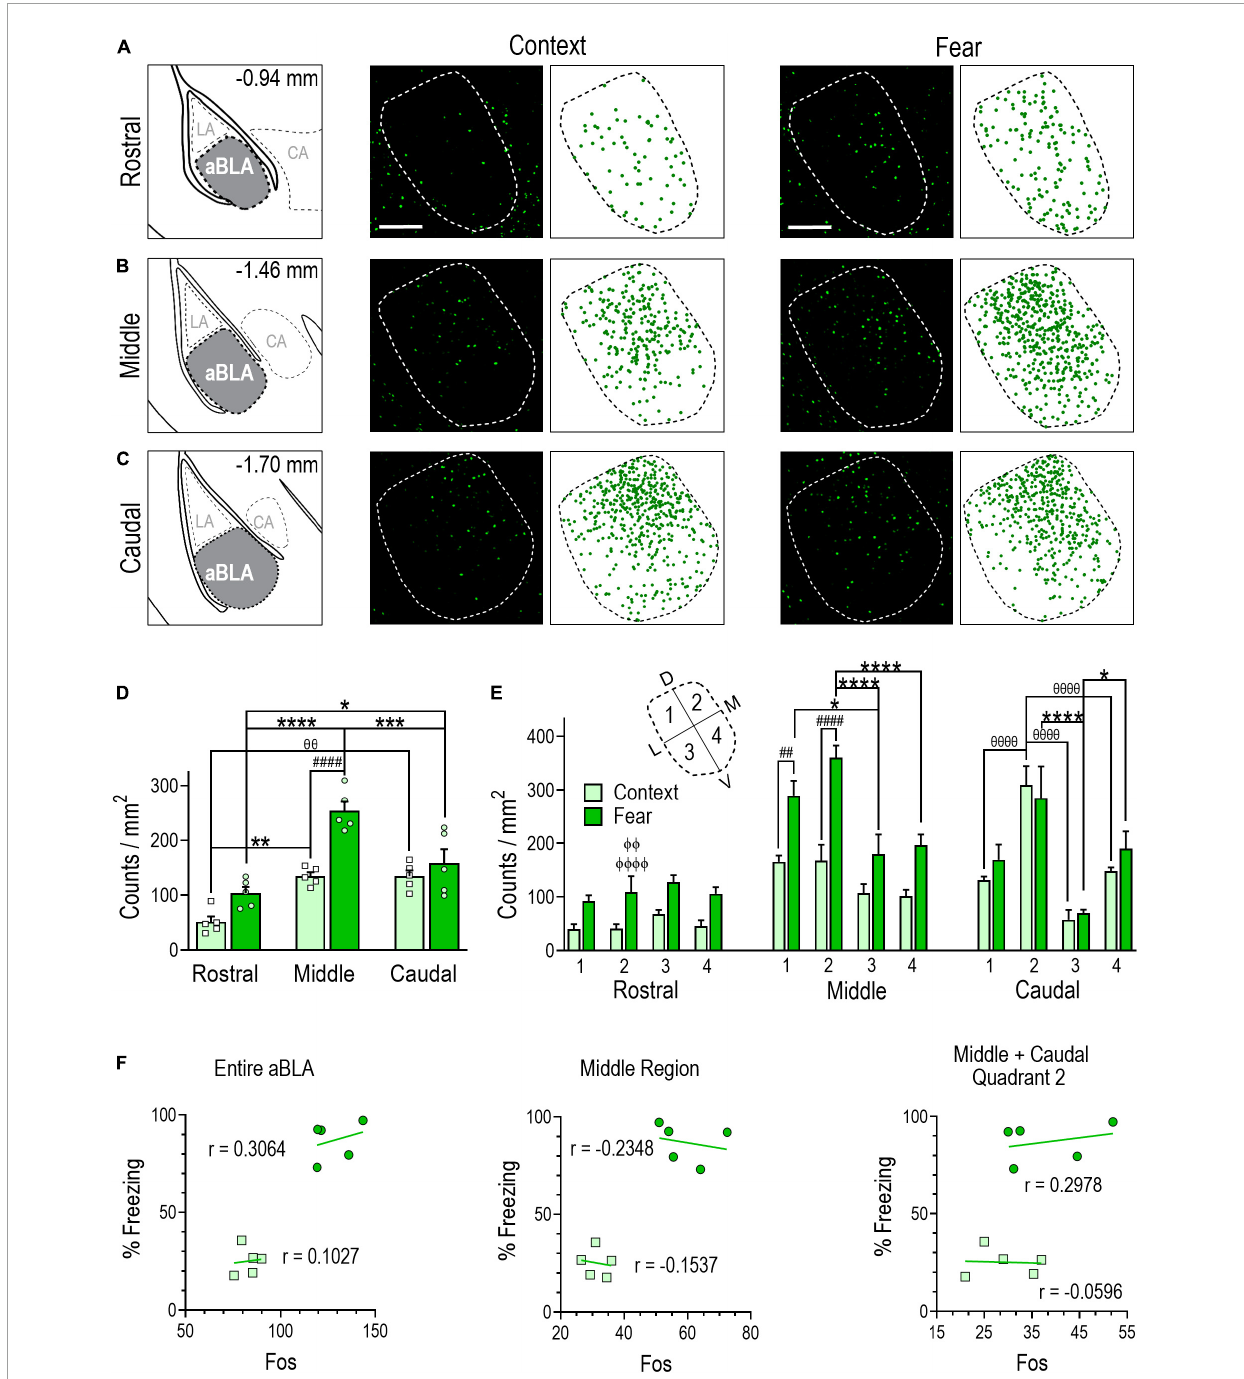
FIGURE3 Remote contextual fear memory recall recruits an enlarged neuronal ensemble in the aBLA. (A–C) Stereotaxic plate drawings of aBLA sub-regions (left), representative images of Fos + (green) neurons activated during remote contextual memory recall and their summary distribution plot (center, n = 5 mice), and representative Fos + (green) neurons activated during remote contextual fear memory recall and their summary distribution plot (right, n = 5 mice). (A) Rostral sub-region. (B) Middle sub-region. (C) Caudal subregion. Scale bar (top, left) = 200 µ m. (D) Average density of Fos + neurons in each analyzed aBLA sub-region in context and fear groups. ** P = 0.0019, θθ P = 0.0018 between sub-regions in the context group. * P = 0.0490, *** P = 0.0004, **** P < 0.0001 between sub-regions in the fear group. #### P < 0.0001 between groups. Two-way ANOVA with Sidak’s post-test. (E) Distribution of Fos + neurons in quadrants (inset) of the rostral, middle, and caudal aBLA. Middle: ## P = 0.0031, #### P < 0.0001, between groups; * P = 0.0168, **** P < 0.0001, between quadrants in the fear group. Caudal: θθθθ P < 0.0001, between quadrants in the context group, * P = 0.0423, **** P < 0.0001, between quadrants in the fear group. φφ P = 0.0015, φφφφ P < 0.0001 between sub-region and within-fear and within-quadrant. Three-way ANOVA with Tukey’s post-test. Data are mean ± SEM. (F) Correlations showing the relationship between the amount of time mice spent freezing during remote context memory (squares) or fear memory (circles) recall and Fos + counts in the entire aBLA (left), its middle sub-region (center) and in quadrant 2 of the middle and caudal sub-regions (right). In each graph, lines represent the least squares regression for each correlation. Within each treatment group, Pearson’s coefficients (r) were not significant for any correlation. Between groups, Fisher’s z transformation was applied and coefficients (r’) were not different between groups for any correlation (see Supplementary Table 1